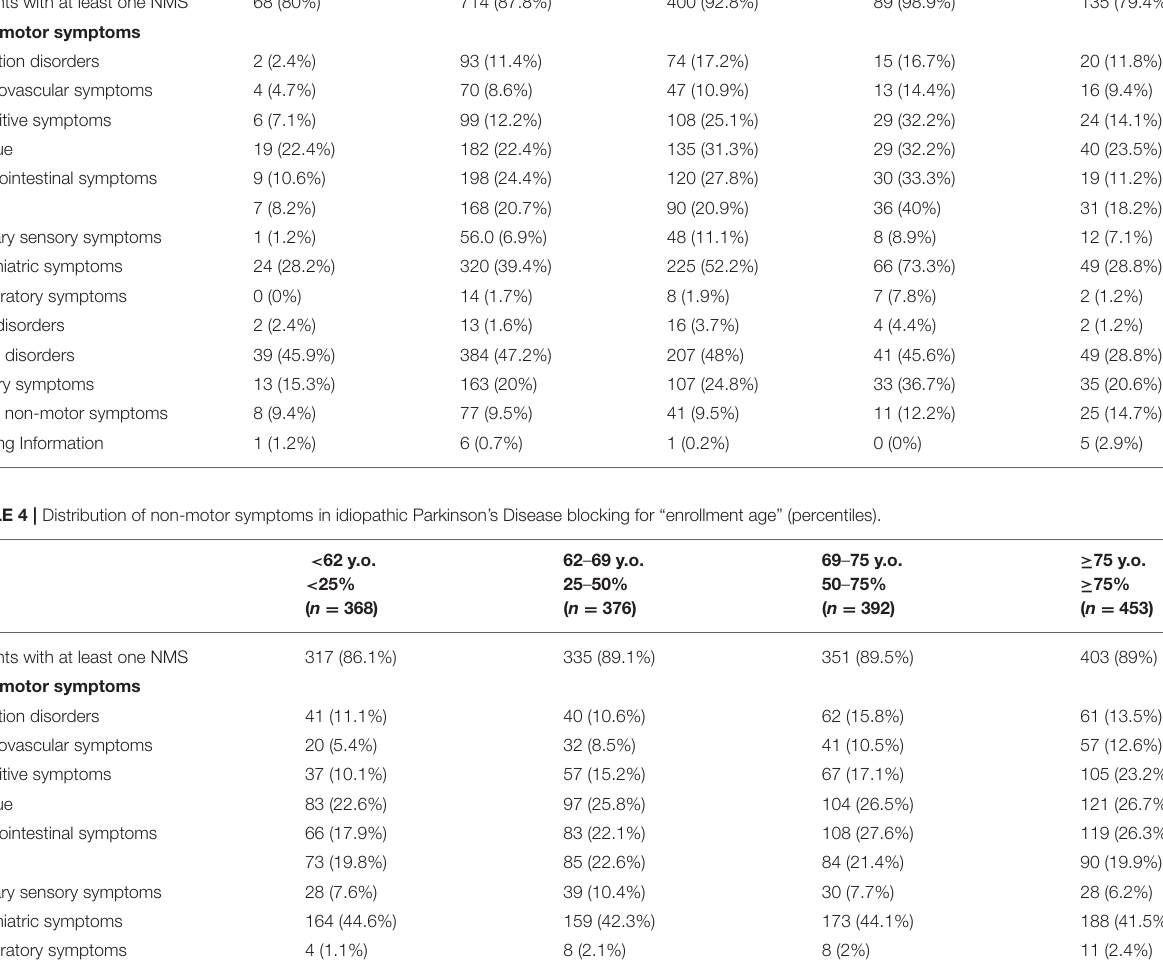
TABLE 3 | Distribution of non-motor symptoms in idiopathic Parkinson’s disease blocking for H and Y score. Patients with at least one NMS